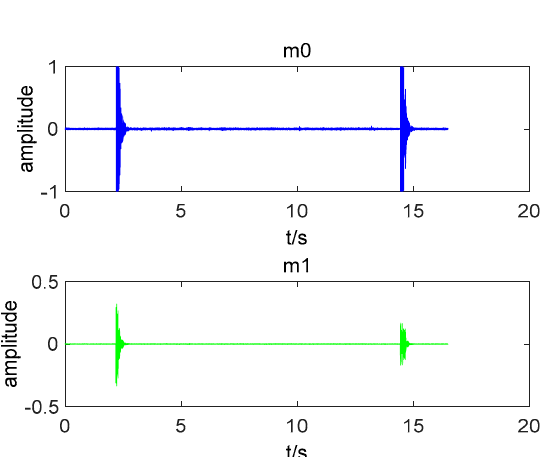
Figure 14. The waveform of sound signals received by m0 and m1.